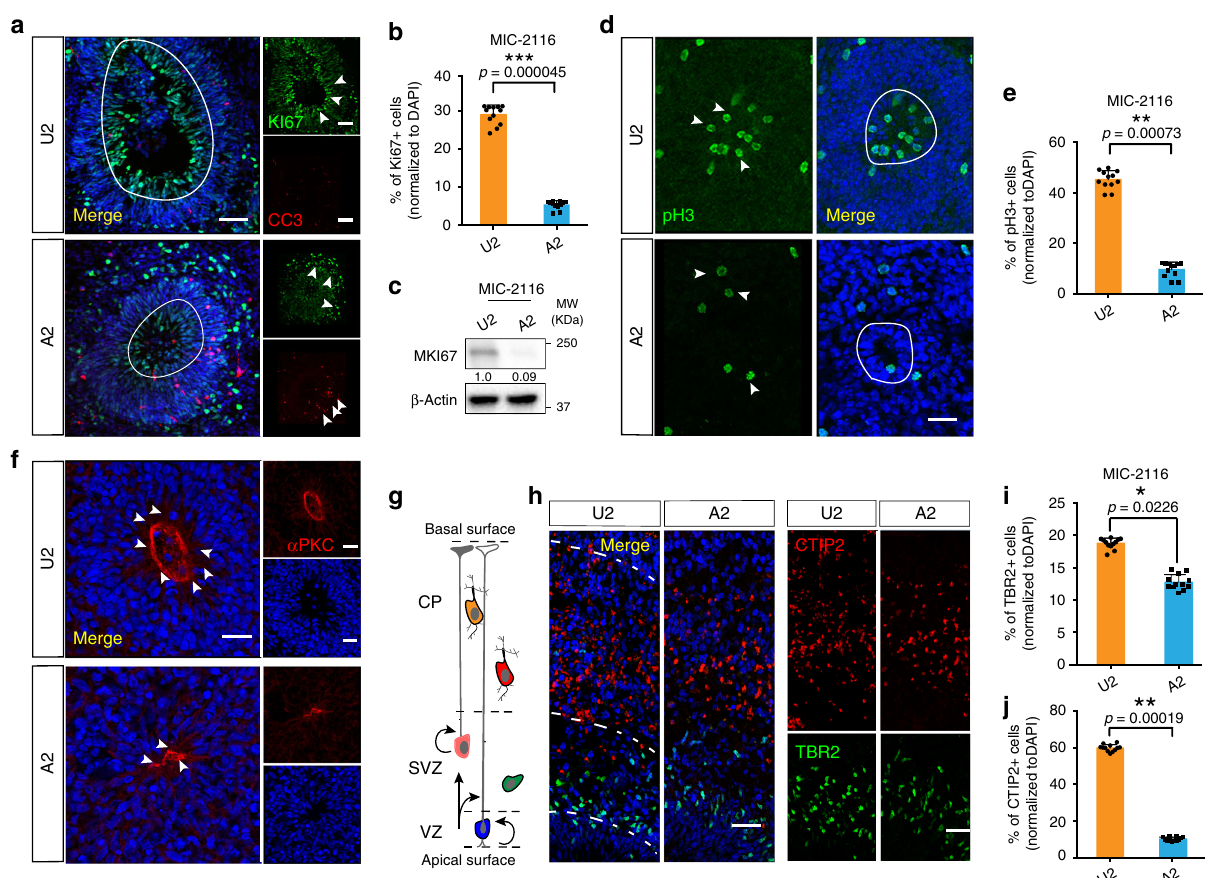
Fig. 5 Reduced proliferation in affected cortical organoid radial glial cells. a Reduced VZ-Ki67 + and increased CC3 + in affected COs at div 52. VZ regions: circle. Ki67 + and CC3 + cells; arrows. Scale bar = 100 µ m. b Ki67 + cells normalized to DAPI + cells; n = 12. c Reduced Ki67 levels in COs from affected at div 52; β -Actin loading control. d Reduced phospho H3 + (pH3 + ) cells in affected COs at div 52; VZ regions: circle, pH3 + cells: arrows. e Quanti fi cation of pH3 + cells normalized to DAPI + cells; n = 12. f Reduced α PKC + apical signal affected COs at div 52 (arrows). g Schematic for layer formation in COs. h COs from affected show less CTIP2 + deep layer neurons. COs at div 52. TBR2 (green): intermediate progenitor cells (IPCs) marked sub-ventricular zone (SVZ) in CO; CTIP2 (red): deep layer neurons marked cortical plate (CP) zone. i , j Quanti fi cation of TBR2 and CTIP2; n = 12. Scale bar = 100 µ m. For ( b , e , i and j ), n represents 3 independent biological replicates generated from iPSCs at different passages (<25), and four times technical replicates for each of the independent biological replicate. Error bar: ± SD in all statistical results. For all statistical, Student t- test with Holm – Š ídák multiple comparison correction was used to determine the two-tailed p value, * p < 0.05, ** p < 0.01, *** p < 0.001. The exact p values for ( b ) is 0.00045, for ( e ) is 0.00073, for ( i ) is 0.0226 and for ( j ) is 0.00019. All data are presented as mean values ±SD. Source data are provided as a Source Data fi